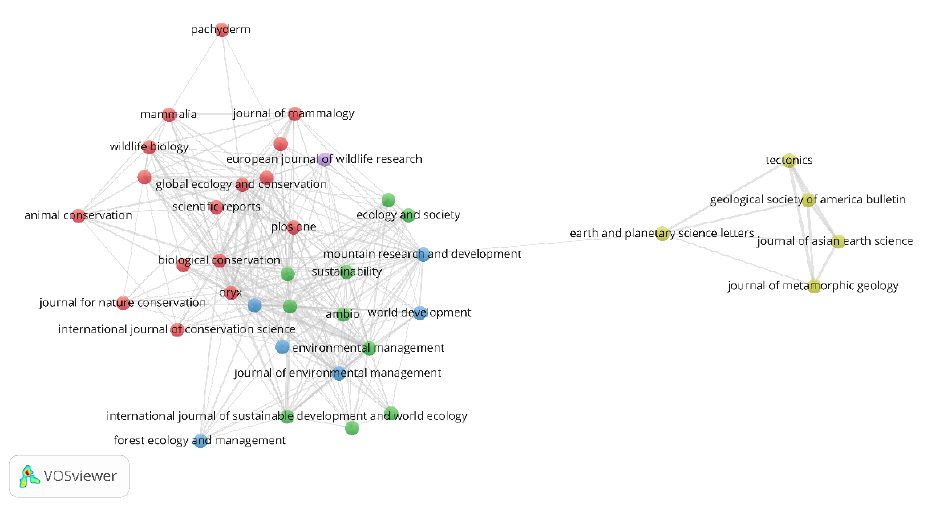
Figure 4. Journals citation correlation.